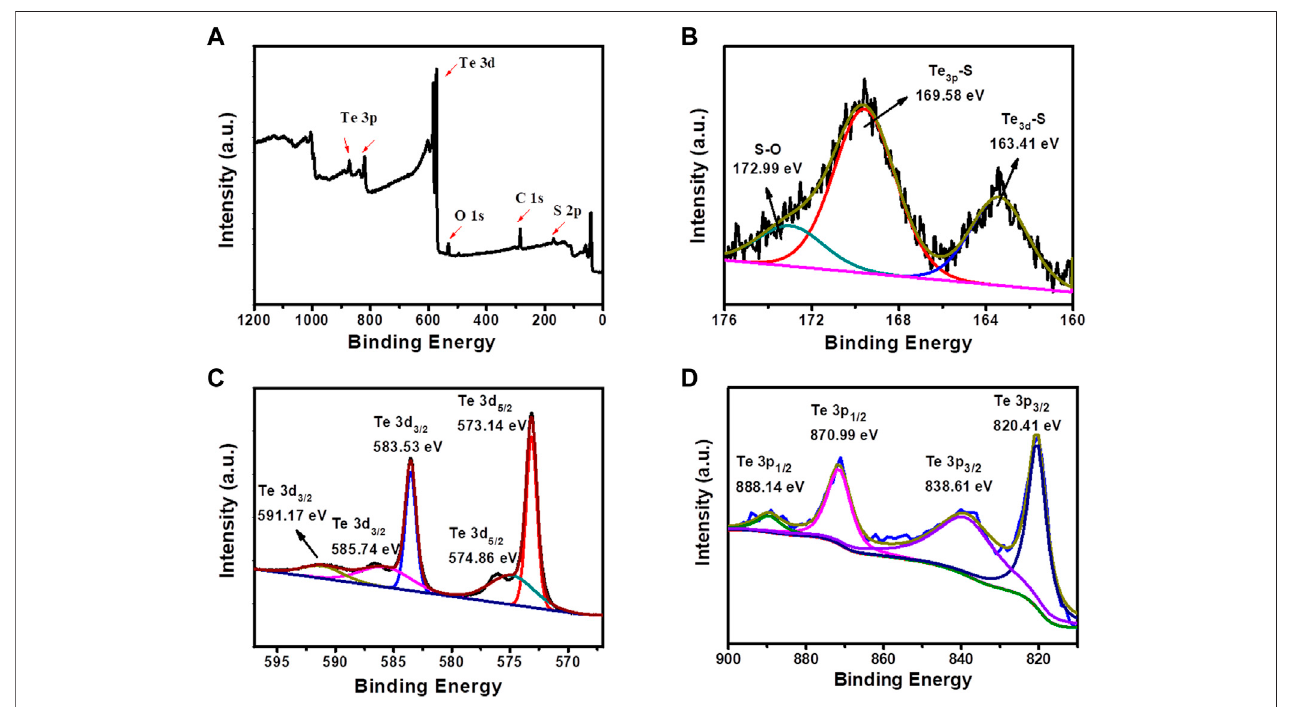
FIGURE 3 | XPS spectra of Te x S y products prepared at Na 2 S concentration of 2.0 mol L − 1 : (A) Survey spectrum, (B) S 2p, (C) Te 3d, (D) Te 3p.